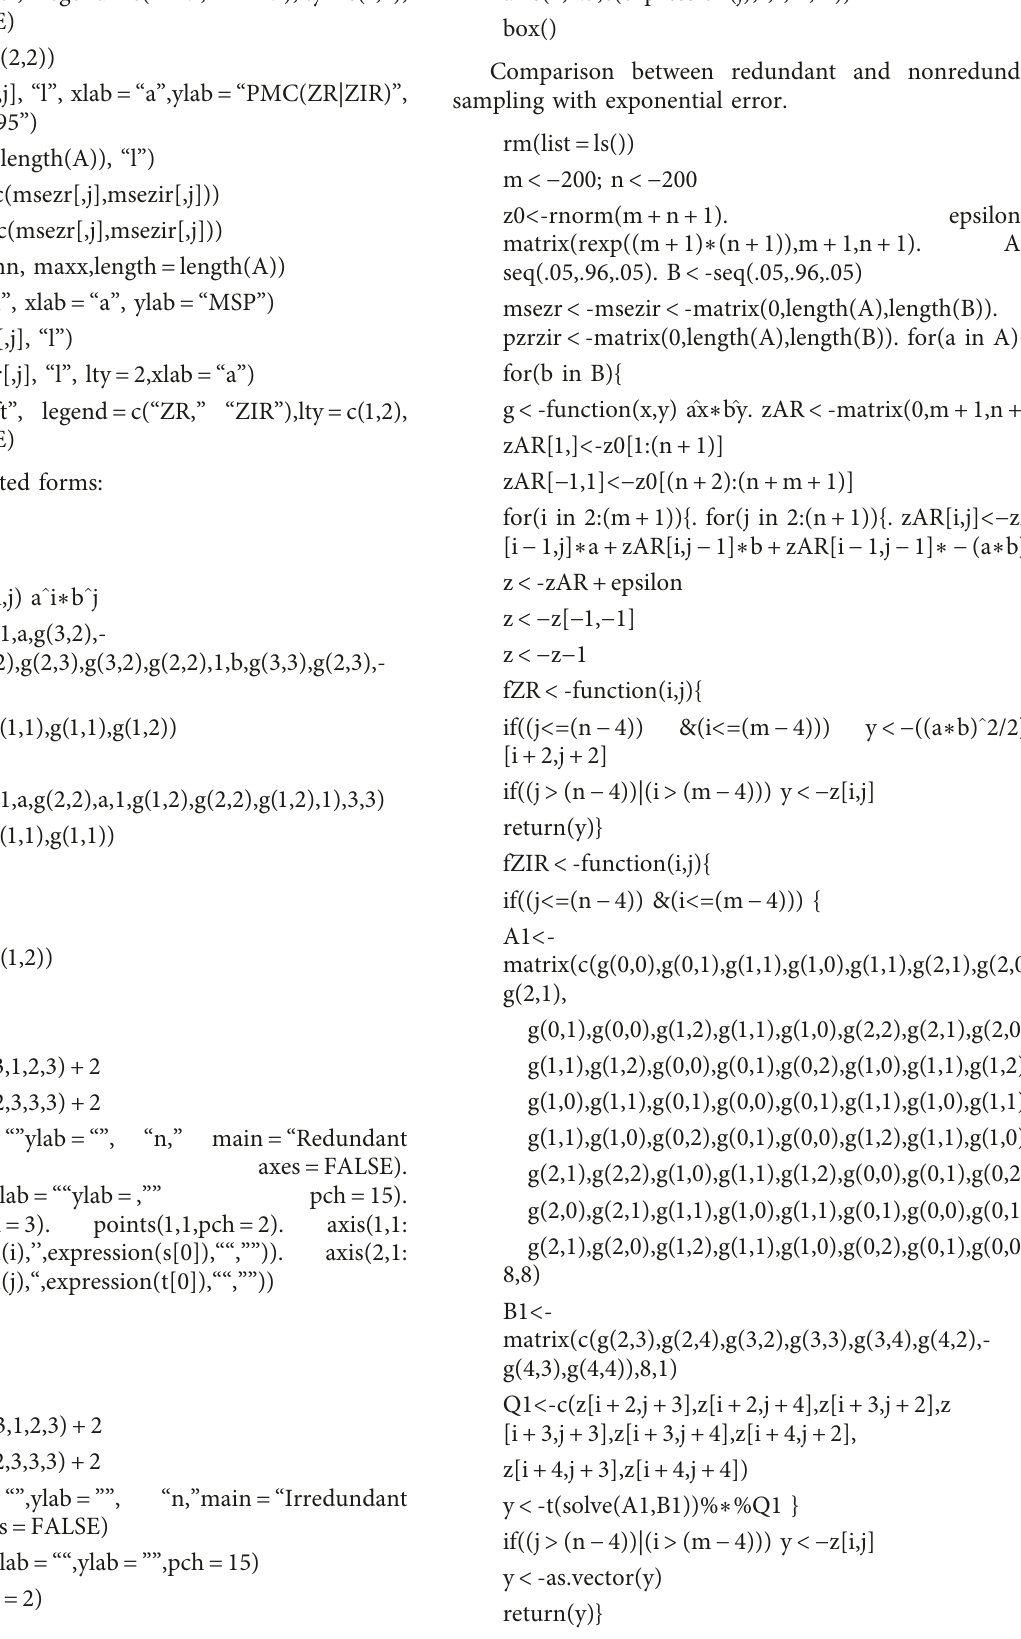
“n,” main � “Redundant axes � FALSE).